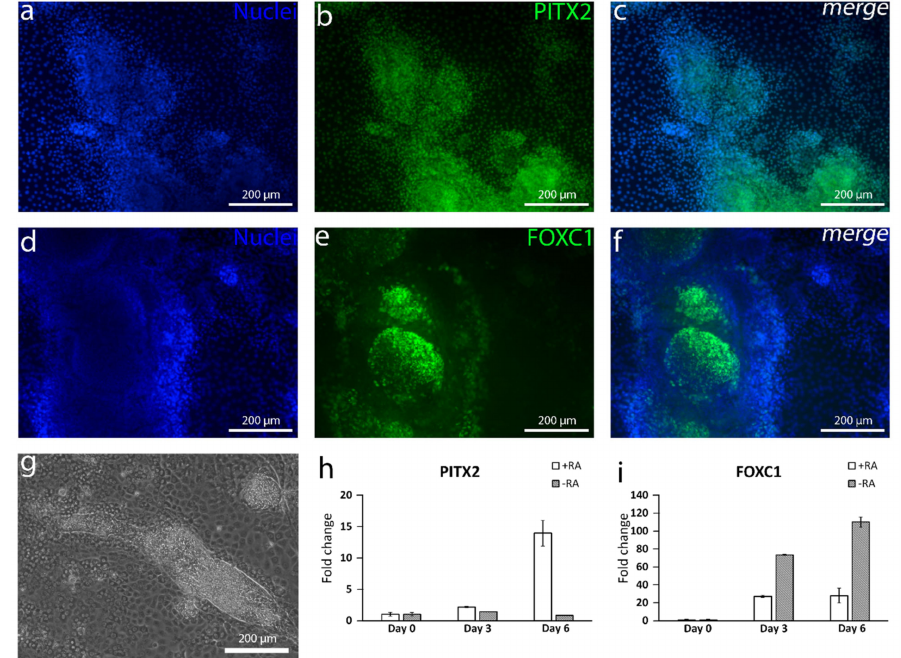
Figure 5. Expression of common periocular mesenchyme (POM) markers in the differentiated cell culture. After 11 days of differentiation, ( a – c ) the paired-like homeodomain transcription factor 2 (PITX2) expression is stronger in the thick mesenchyme-like structures. ( d – f ) Forkhead box C1 (FOXC1) can be seen in the same structures as well. ( g ) POM-like structures are surrounded by CEnC-like cells. ( h ) RT-qPCR analyses of the differentiating cells with or without retinoic acid (RA) shows an increasing expression of PITX2, especially in +RA but not in − RA. ( i ) The FOXC1 expression increases in both circumstances but more in − RA. Data conducted with the Regea08/017 hESC line. RT-qPCR analyses included three technical replicates. Scale bar ( a – g ) 200 µ m.